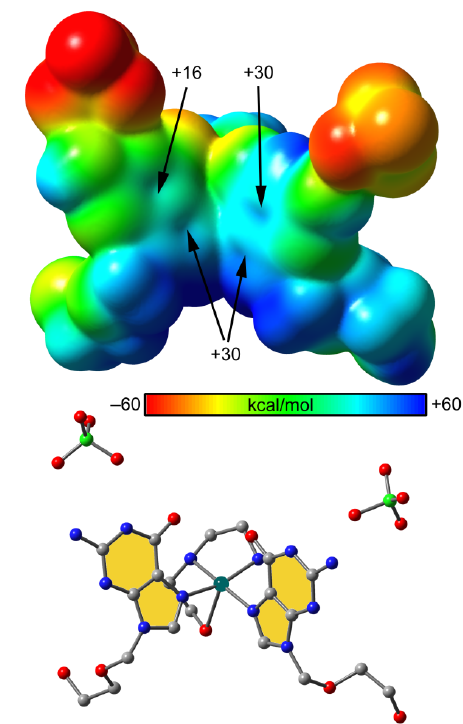
Figure 6. Top: MEP surface plotted onto the 0.001 a.u. isosurface. The values at selected points of the surface are given in kcal/mol. Bottom: Fragment used for the MEP (unit A, compound 3 ) at the same orientation used for the MEP surface representation (H-atoms omitted).